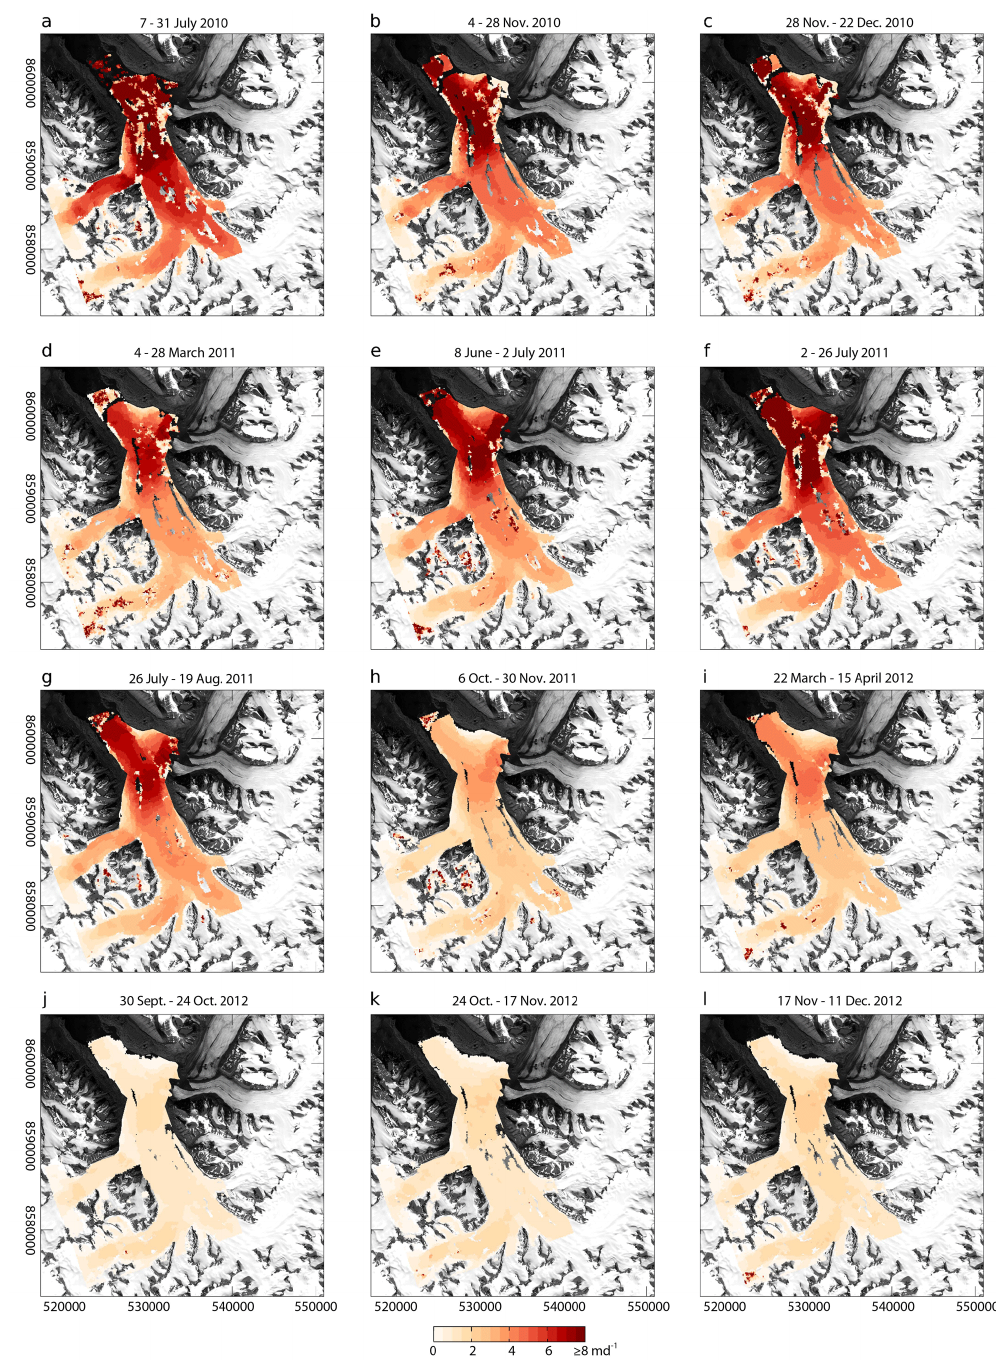
Fig. 6. Surge advance velocity distribution in the different branches of NGS in 2010–2012. Velocities are estimated using offset tracking of 24-day pairs of Radarsat-2 fine-mode SAR data. The border between the glacier terminus and sea ice appears as a black, curved area. Colour scales are enhanced to display velocity variations. Background image by SPOT SPIRIT 2008 ©